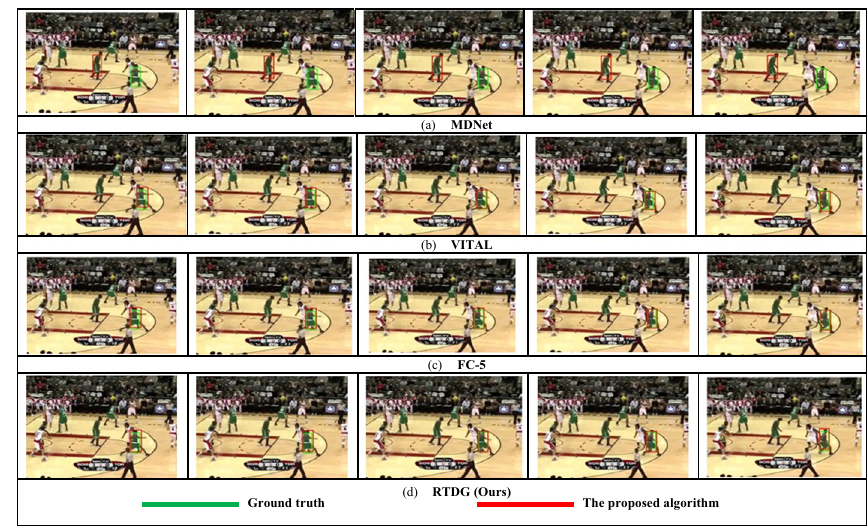
Fig. 11 Tracking results of the compared trackers on the ’Basketball’ video (frames: 484 to